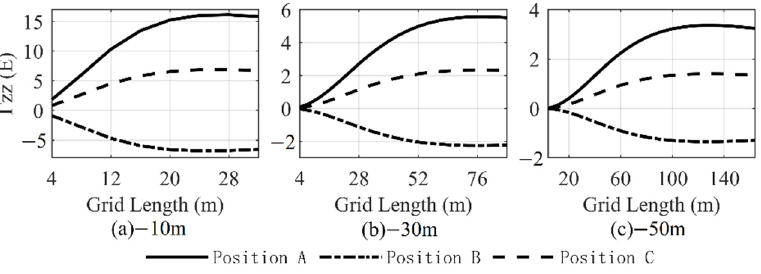
Figure 7. Relation between gradient and integration range. Table 2. Variation of gradient with integration range at 10 m below mean sea level. Side Length of Integration Area (m)